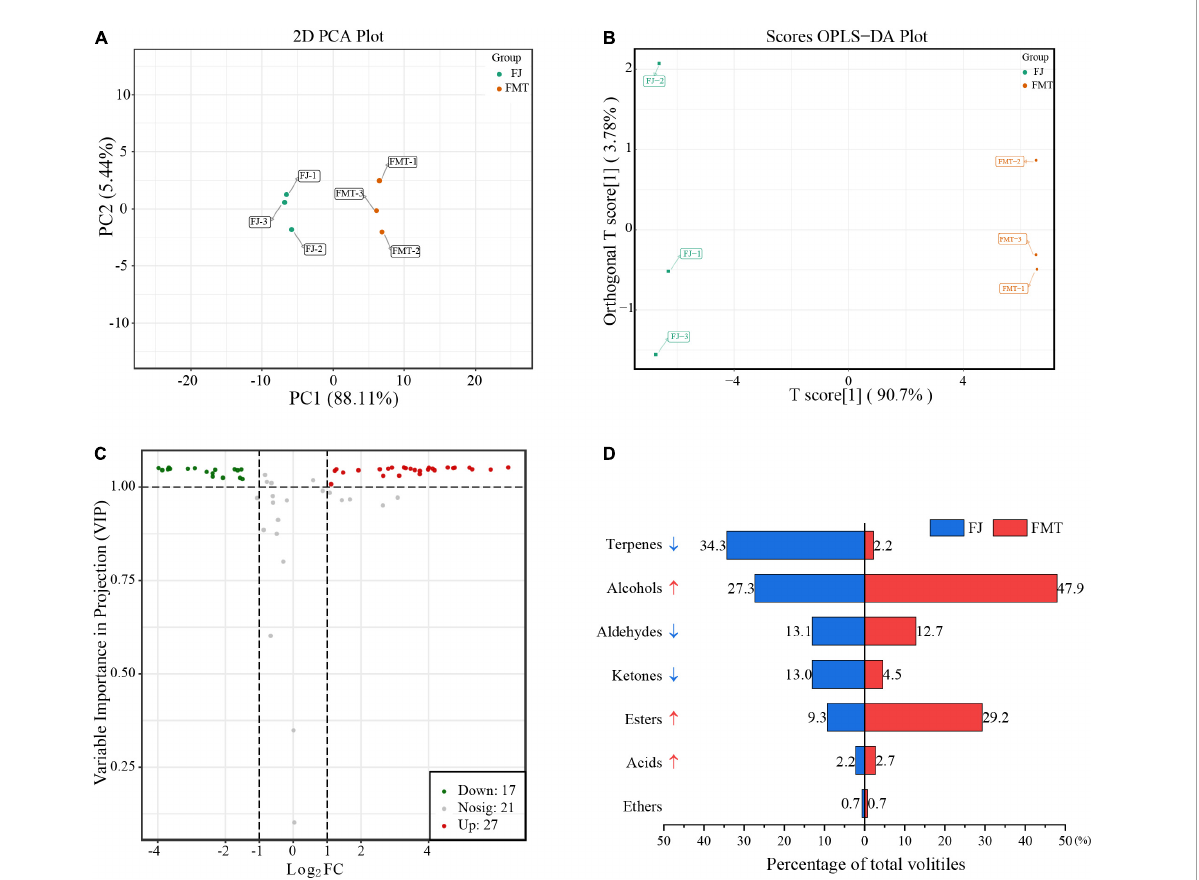
FIGURE5 Multivariate analysis of volatile compounds. (A) PCA analysis of volatile compounds from FJ and FMT. (B) OPLS-DA model plot of the volatile compounds from FJ and FMT. (C) Volcano plot of differential metabolites. (D) Volatile substances changes of different categories between FJ and